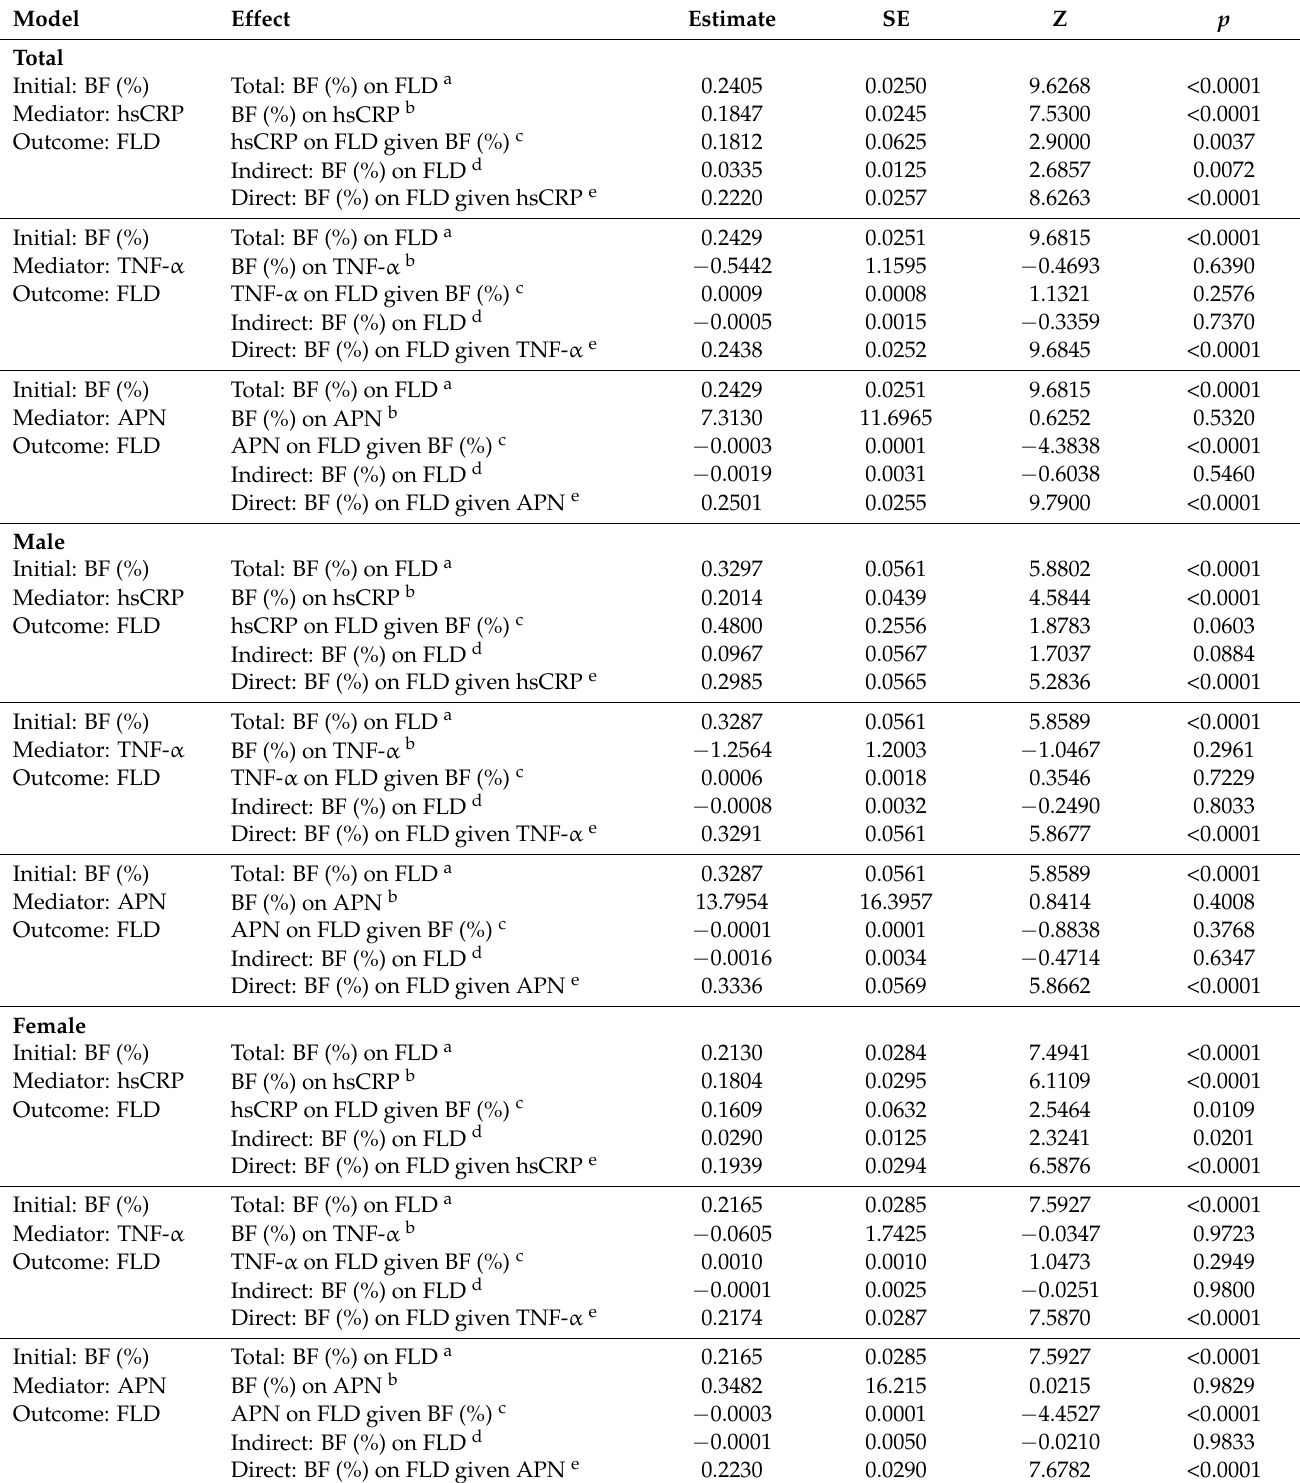
Table 2. Mediation Analysis in the total population and stratified by